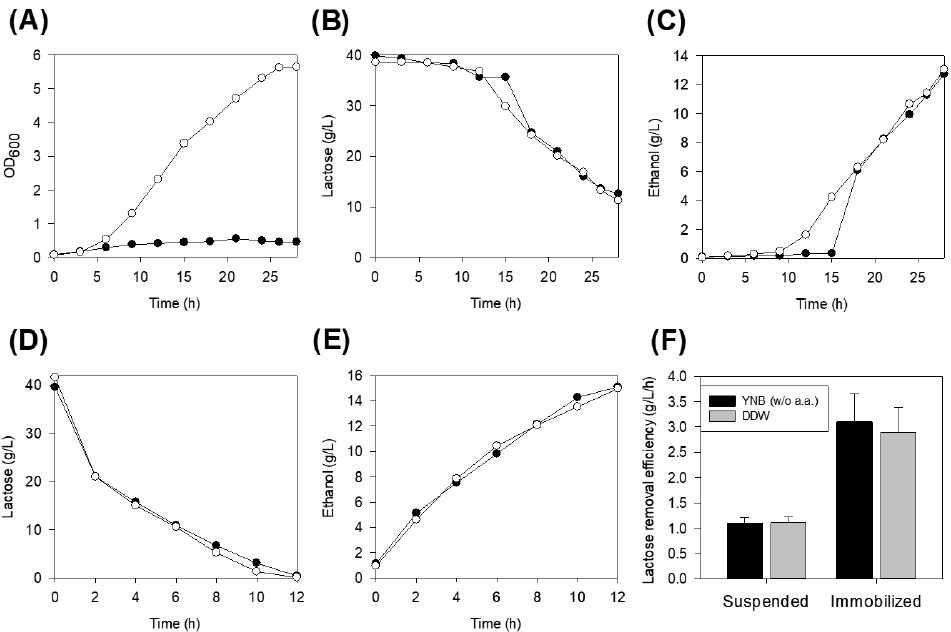
Figure 1. Lactose assimilation activity by Kluyveromyces lactis in YNB media without amino acid (open circle) and distilled water (filled circle). Cell growth, lactose, and ethanol production in